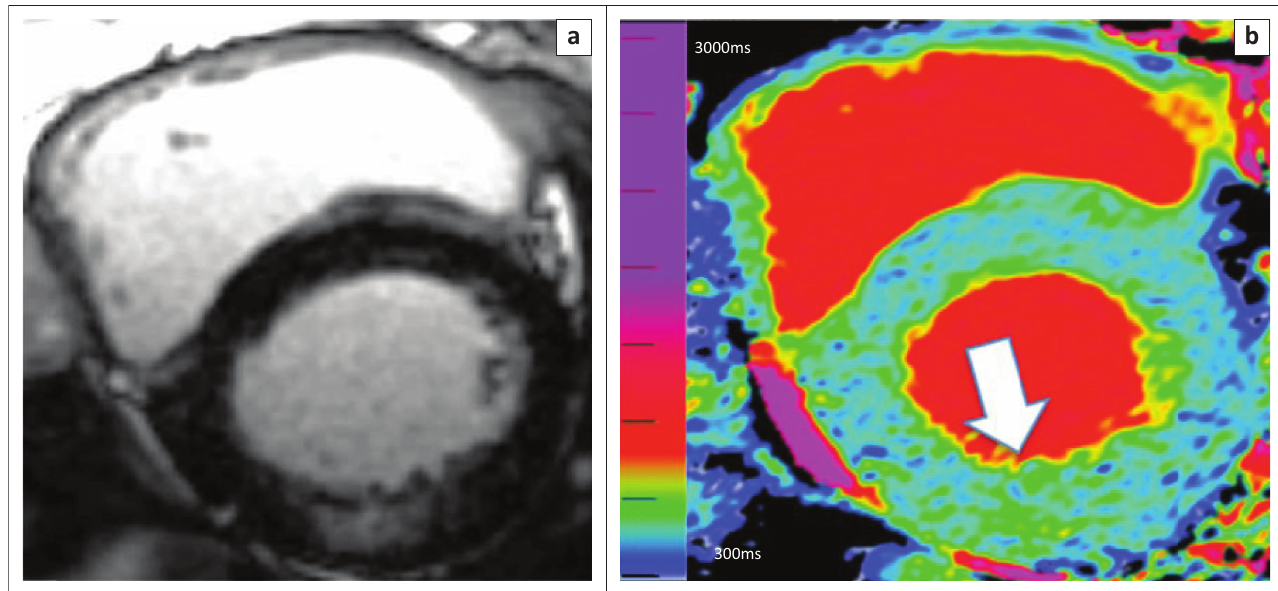
FIGURE 4: LGE images: (a) showing LGE in the basal infero-lateral wall and corresponding T1 map (b). Note the general blue colour of the whole myocardium confirming low T1 values (seen in fat and iron deposition) and that the area of LGE (seen in the mid wall of the basal inferolateral wall) corresponds to an area of green colour representing normal T1 values (highlighted by the arrow). This is probably pseudo-normalisation in the presence of fibrosis (as fibrosis increases T1